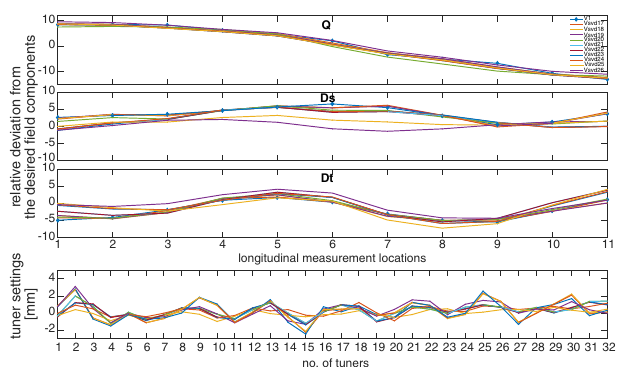
FIG. 12. The plot illustrates the change of the relative longi- tudinal field distributions of the Q, Ds, and Dt components by moving all 32 tuners one by one. The same normalization factor has been used for all